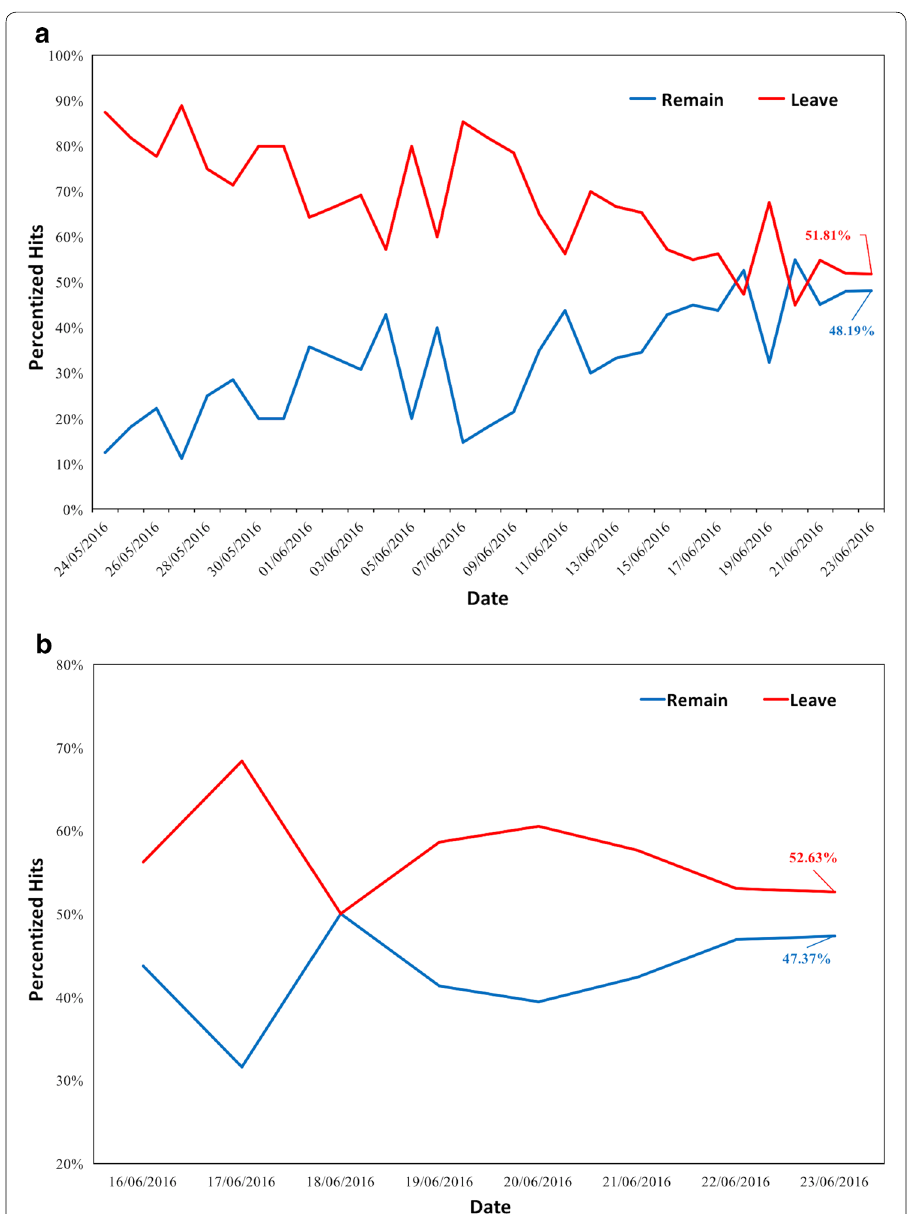
Fig. 2 ‘Remain’ vs. ‘Leave’ Percentized Hits ( a ) May 24th to June 23rd, ( b ) June 16th to